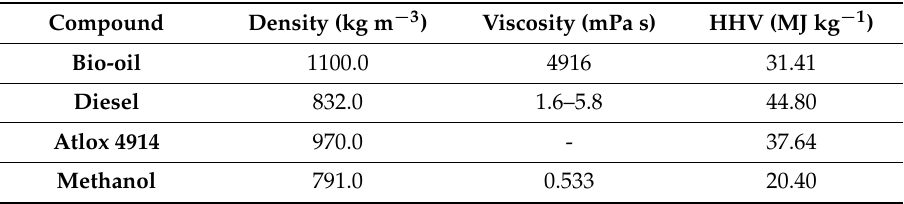
Table 2. Properties of the bio-oil, diesel, surfactant, and